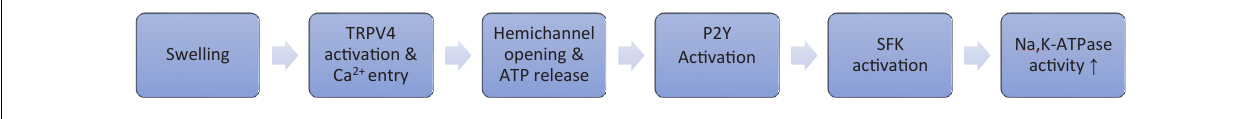
FIGURE 2 | Swelling activates TRPV4. Schematic diagram of the TRPV4-initiated signaling cascade that culminates in an increase of Na, K-ATPase activity.